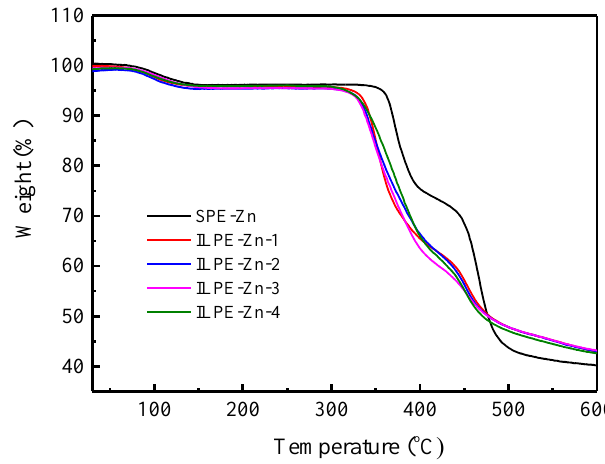
Figure 6. TGA curves of the ILPE membranes with different EMITf contents.